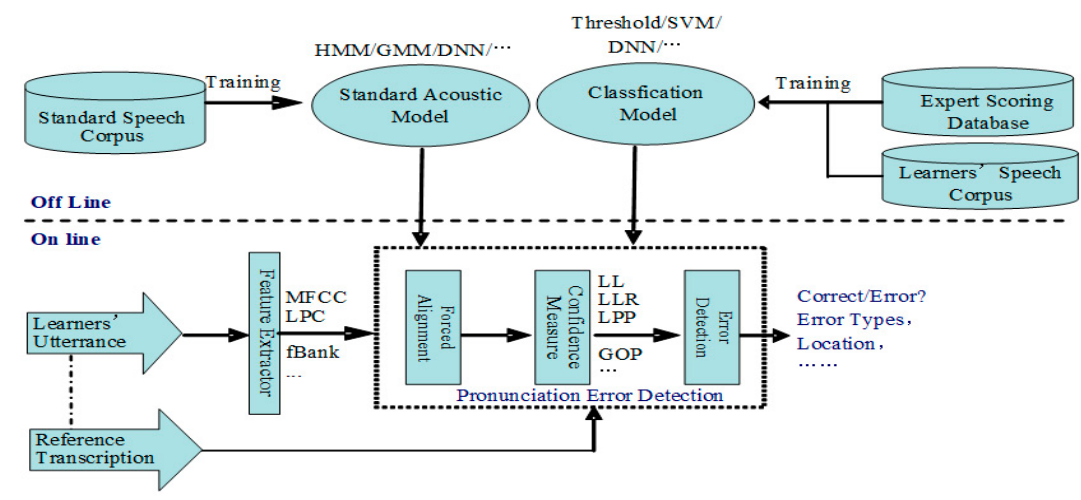
Figure 1. Framework of a typical automatic pronunciation error detection (APED) system.